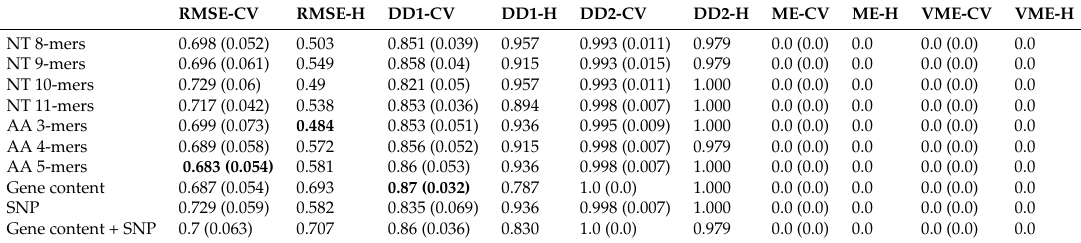
Table A13. C. jejuni –azithromycin.